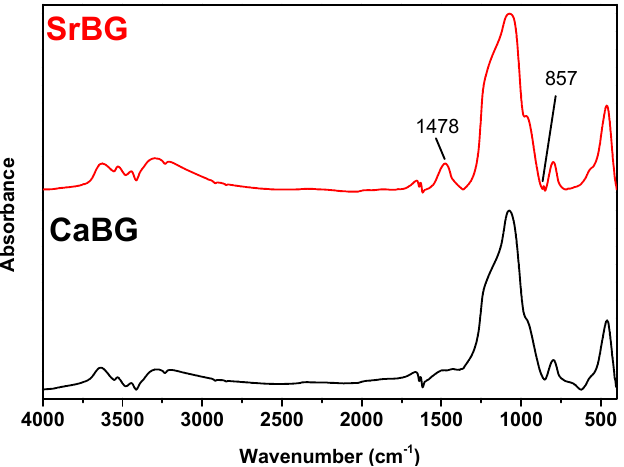
Figure 2. FTIR spectra of CaBG and SrBG BGs.